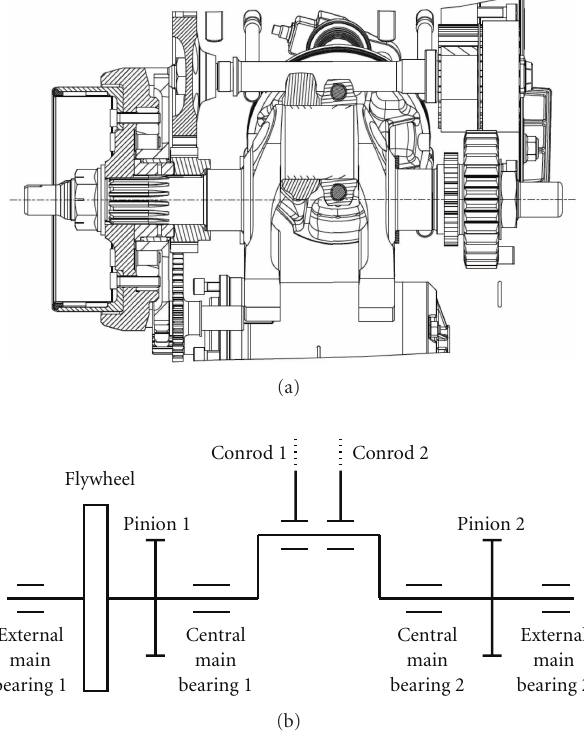
Figure 1: Drawing and functional schematic of the cranktrain under